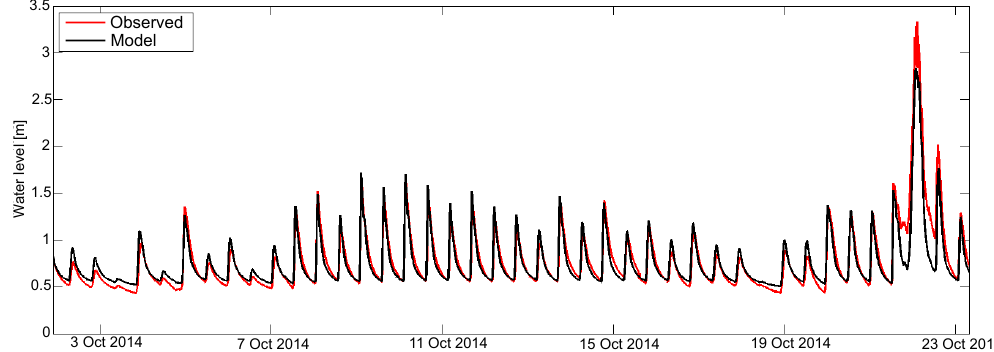
Figure 5. Observed and simulated water levels in the lagoon from 2–23 October 2014, which contains a fortnightly spring–neap tidal cycle and a storm surge around 22 October.